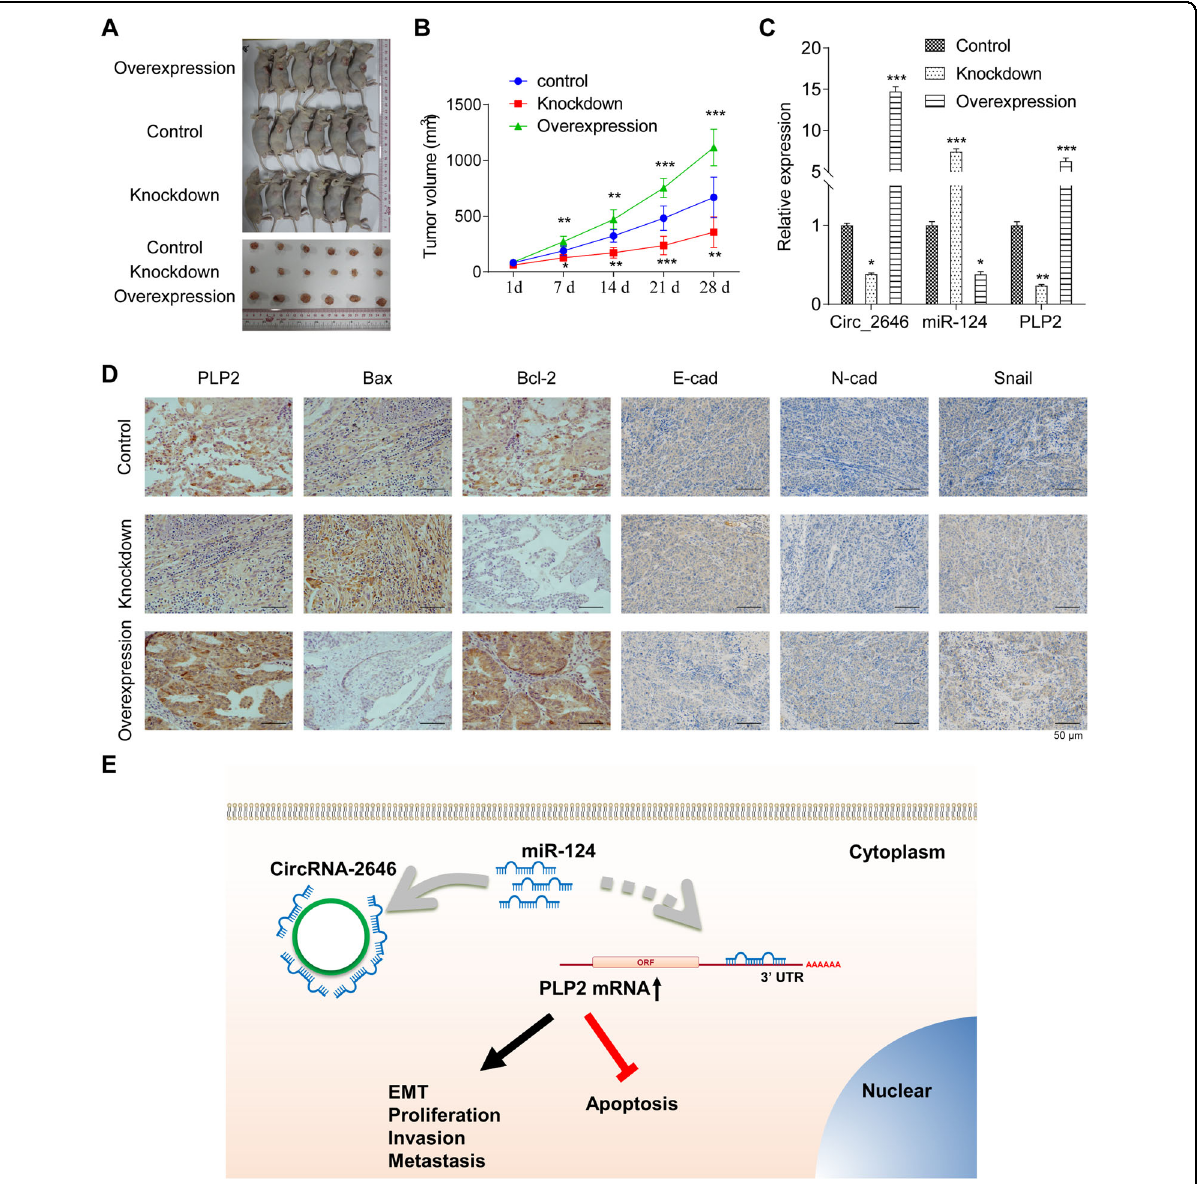
Fig. 6 CircRNA_2646 promoted ESCC development in vivo via regulating miR-124/PLP2. Eca109 cells infected with Lentivirus-pcDNA3.1- circRNA_2646, shRNA-circRNA_2646, or negative control were subcutaneously injected into the right fl ank of nude mice. A The picture of the fi nal tumor from each group. B The tumor volume of each group was calculated and analyzed. C The expressions of CircRNA_2646, miR-124, and PLP2 in tumor tissues were analyzed by RT-qPCR. D The expressions of PLP2, Bax, Bcl-2, E-cad, N-cad, and Snail in tumor tissues were determined by IHC, scale bar, 50 μ m. * p < 0.05, ** p < 0.01, *** p < 0.001. E The proposed pathway of CircRNA-2646/miR-124/PLP2 axis on ESCC progression. CircRNA-2646 functions as an inhibitor of the miR-124/PLP2 signaling pathway to enhance ESCC cell proliferation, migration, invasion, and EMT progress, and inhibit cell apoptosis.